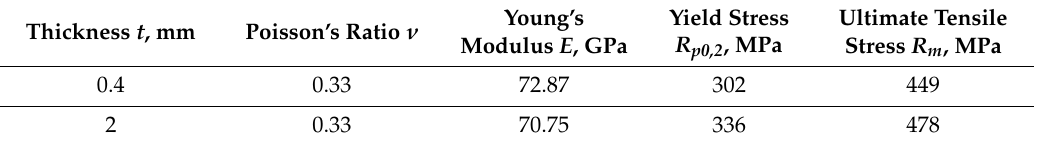
Table 1. Basic mechanical parameters of the 2024-T3 aluminium alloy sheet used.